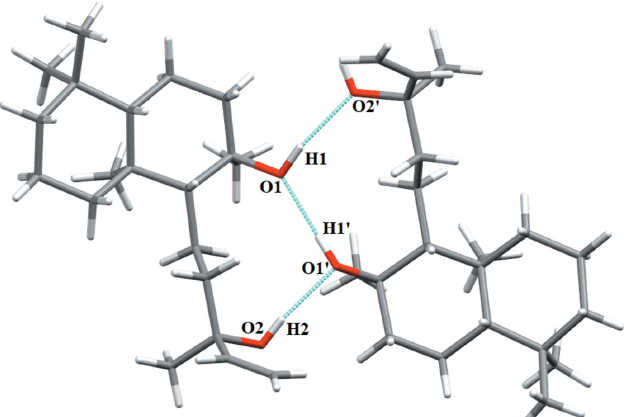
Figure 2 Fragment of 1 showing O—H (cid:2)(cid:2)(cid:2) O hydrogen bonds.